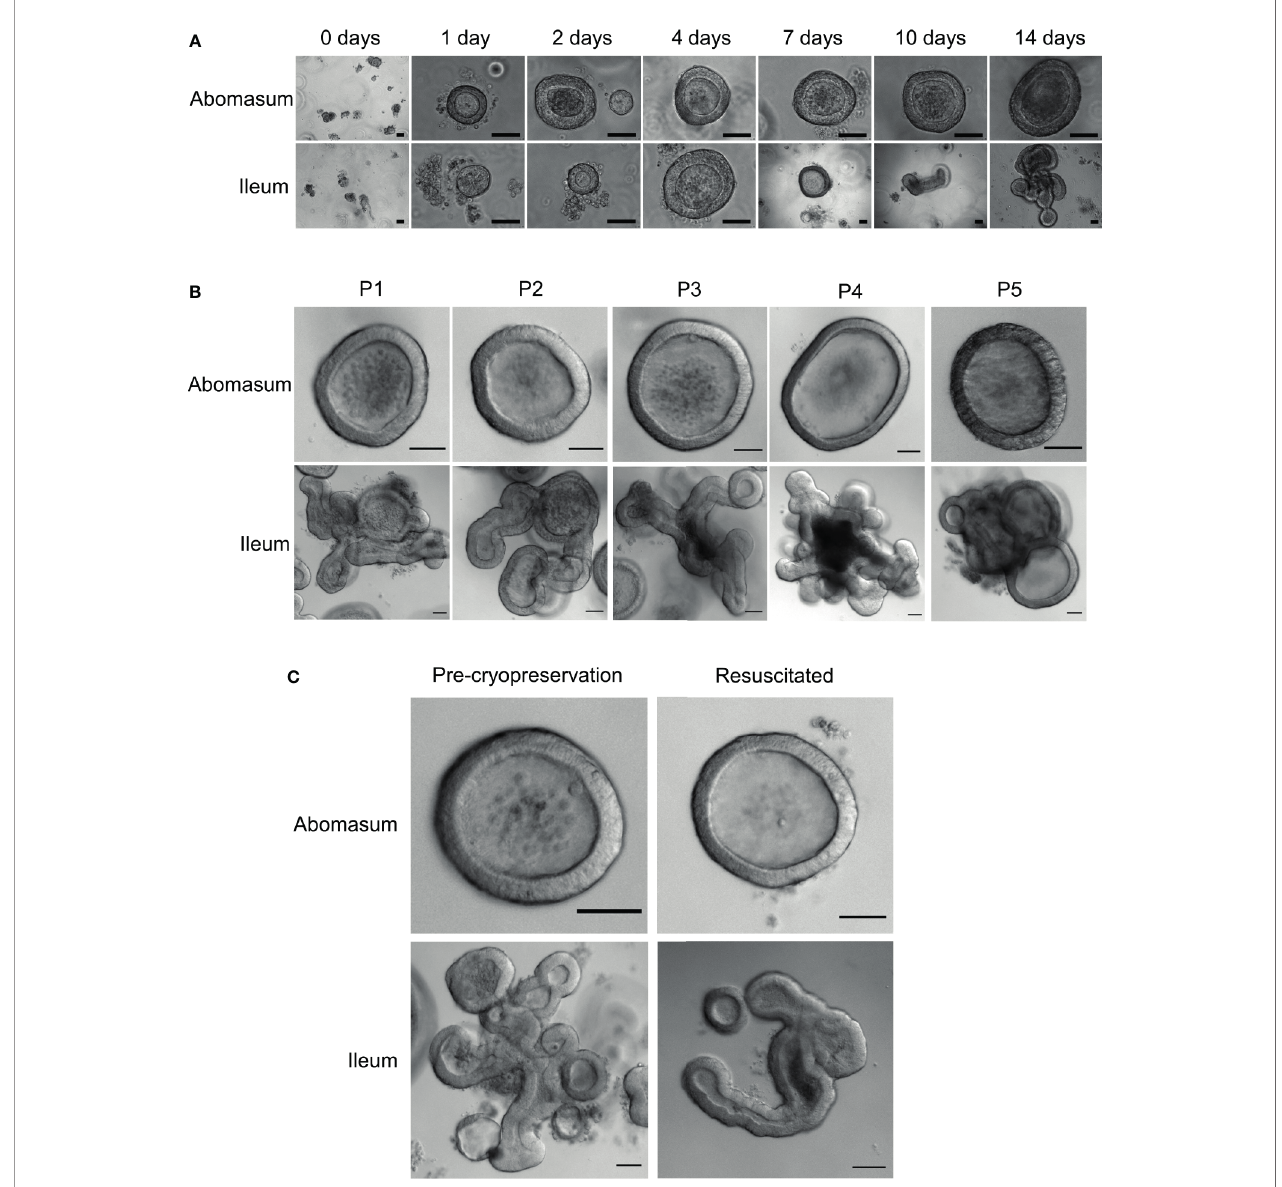
FIGURE 2 | In vitro growth of ovine abomasum and ileum organoids. (A) Representative images of abomasum and ileum organoids grown over 14 days in the same culture conditions. (B) Representative images showing the growth and development of mature abomasum and ileum organoids across multiple consecutive passages (P1 - P5) at seven days of in vitro culture. (C) Representative images of abomasum and ileum organoids grown for seven days, both pre-cryopreservation and after resuscitation. Scale bars = 10